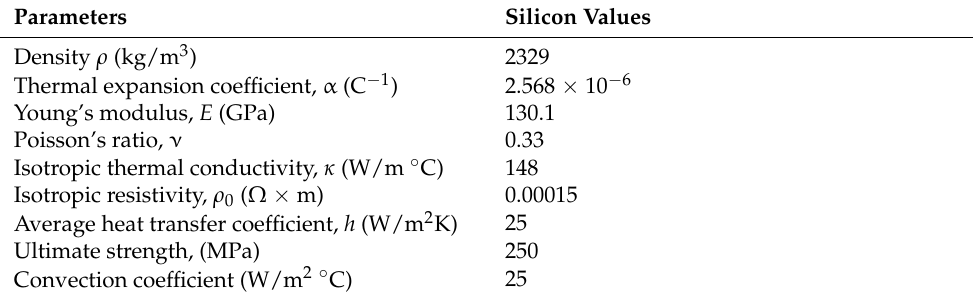
Table 3. Mechanical and electrical parameters of Si [9,24,33,41].